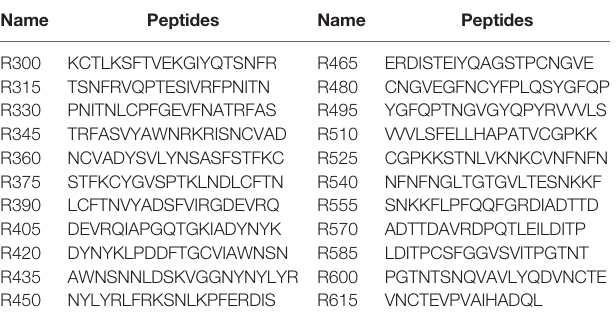
TABLE 1 | Overlapped peptides spanning the RBD of SARS-CoV-2 S protein in this work.